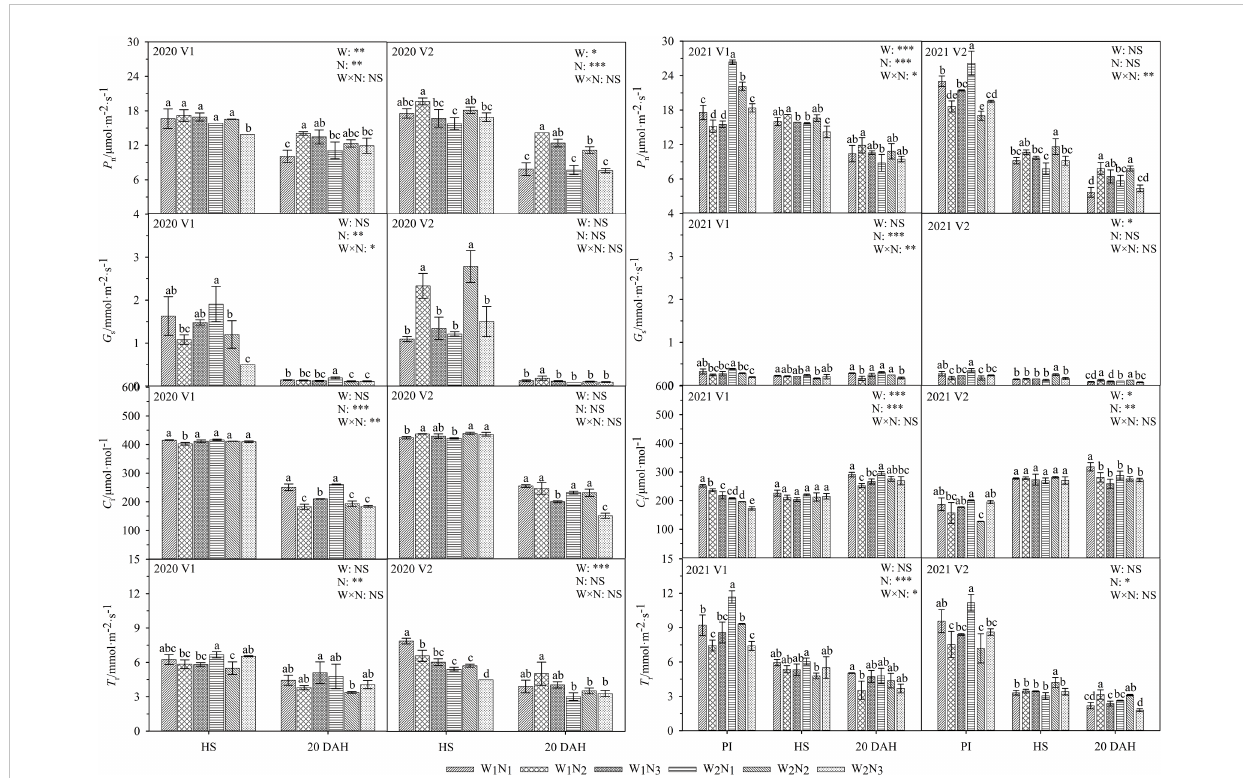
FIGURE 4 Effects of different water and nitrogen treatments on photosynthetic parameters in rice leaves at different growth stages. The data are presented as the means of three replicates (n = 3). Error bars indicate standard error (SE). W 1 and W 2 represent limited irrigation (10200 m 3 ·hm -2 ) and de fi cit irrigation (8670 m 3 ·hm -2 ), while N 1 , N 2 , and N 3 represent different ratios of seedling fertilizer:tillering fertilizer:panicle fertilizer:grain fertilizer (30%:50%:13%:7%; 20%:40%:30%:10%; and 10%:30%:40%:20%, respectively). PI, HS, and 20 DAH represent panicle initiation, heading stages, and 20 days after heading, respectively. V1 and V2 represent T-43 and Liangxiang-3, respectively. * represents a signi fi cant difference at the 0.05 level; ** represents a signi fi cant difference at the 0.01 level; *** represents a signi fi cant difference at the 0.001